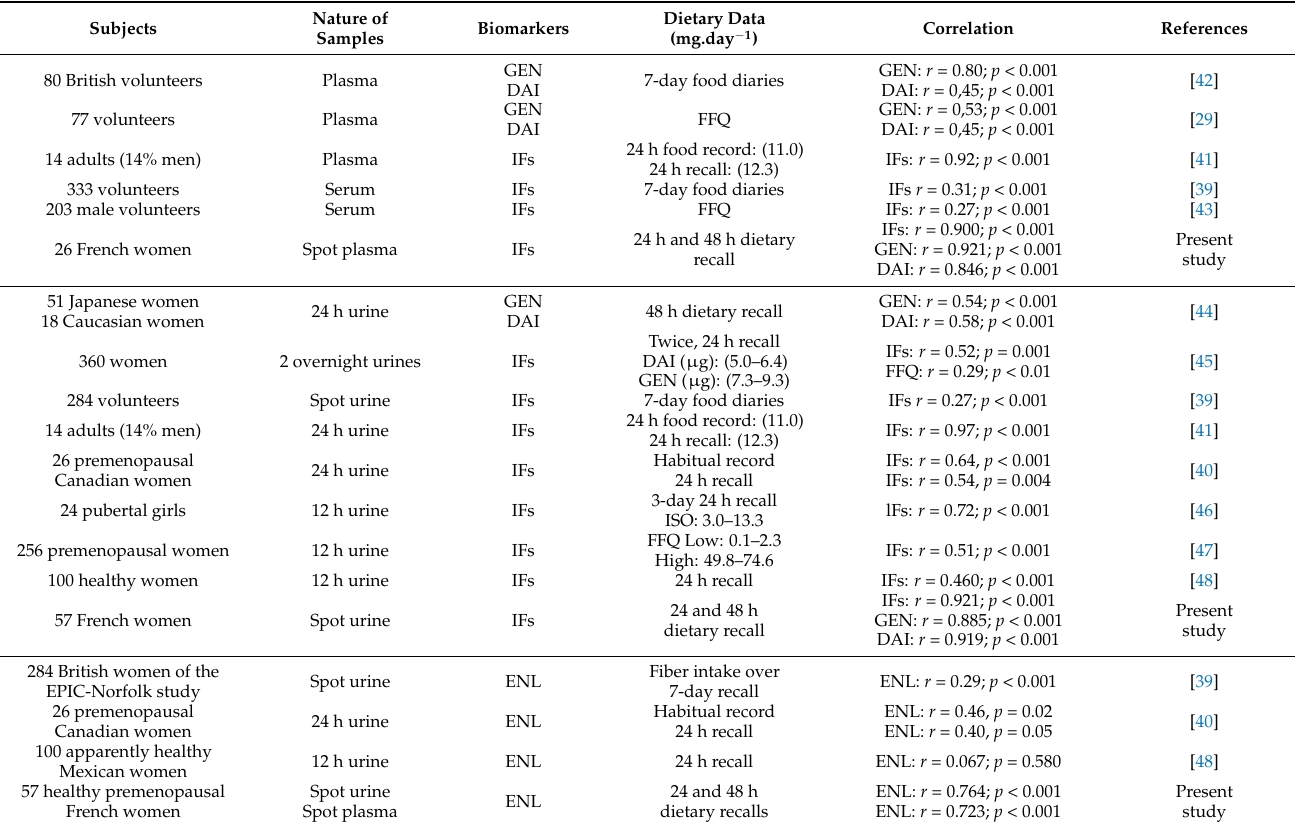
Table 3. Comparisons with other studies connecting PHYTOs in body fluids and estimated dietary intake of